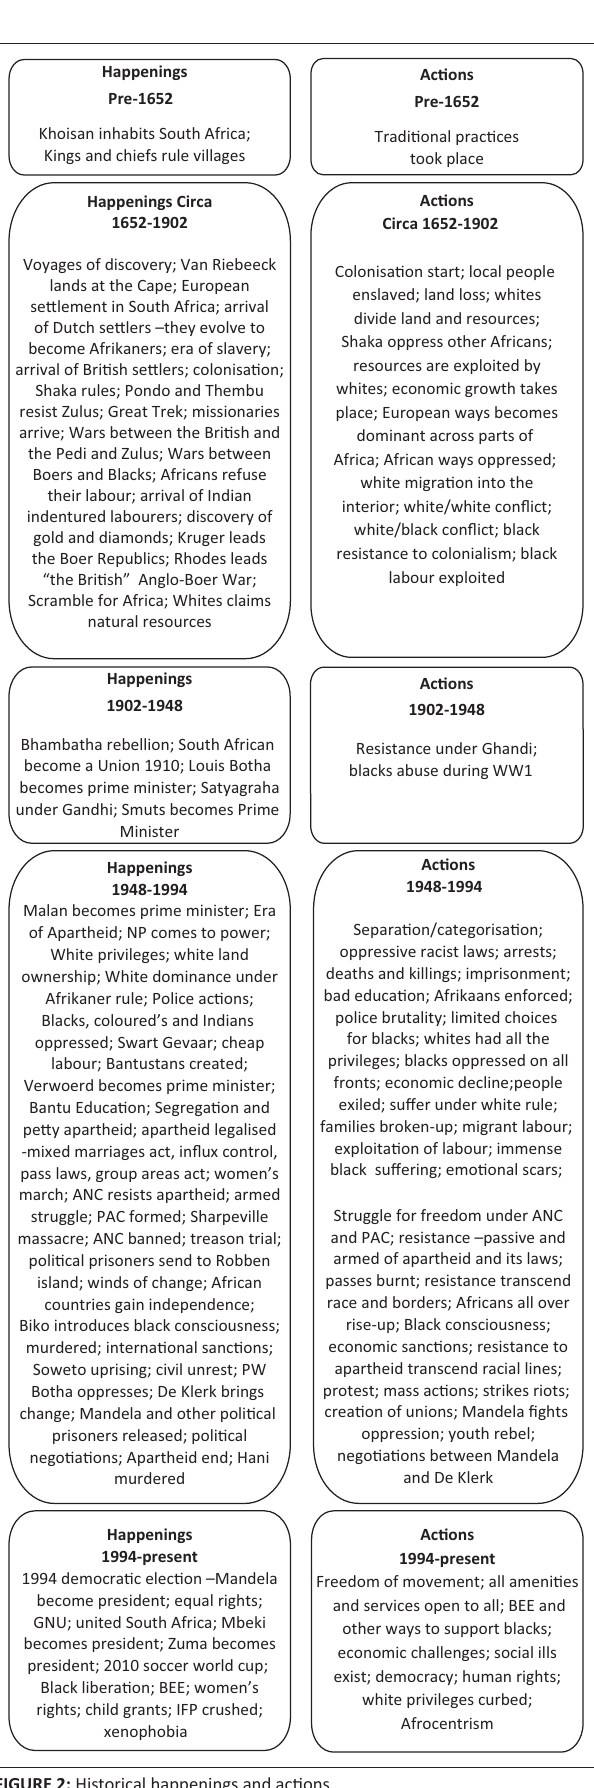
FIGURE 2: Historical happenings and